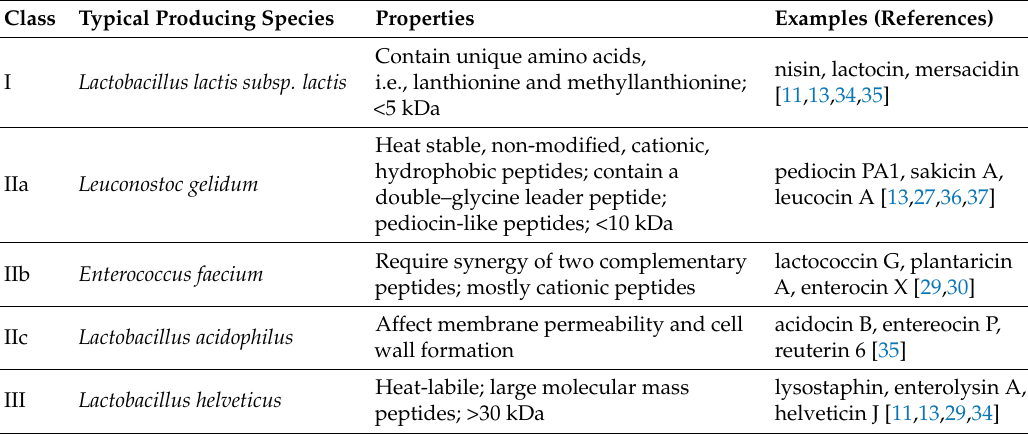
Table 1. Classes and properties of bacteriocins from lactic acid